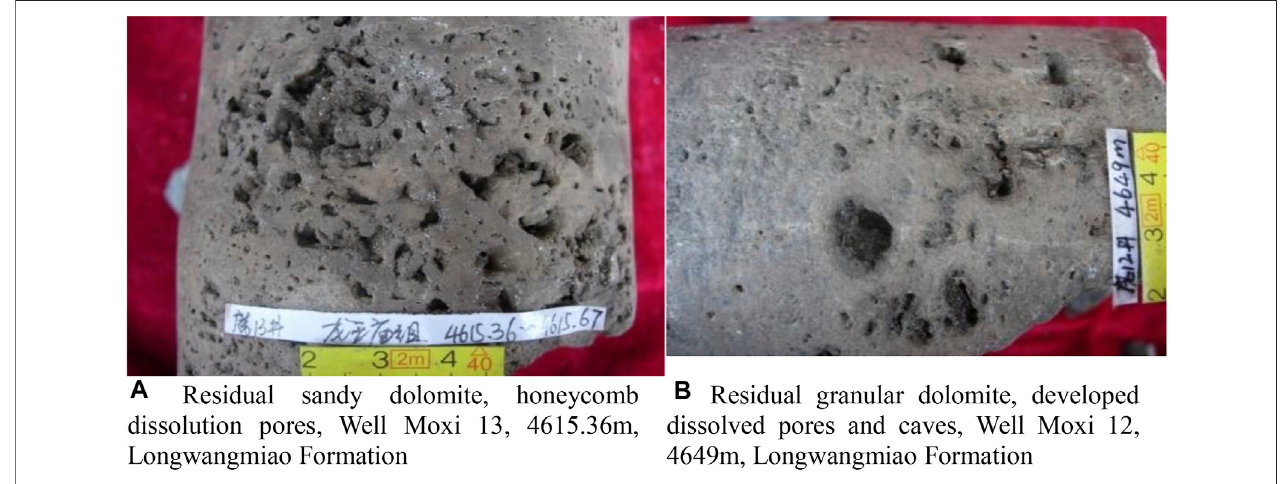
Frontiers in Earth Science |